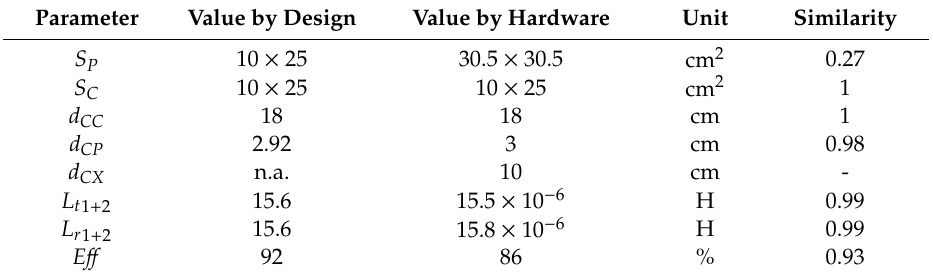
Table 7. Comparison of results between the design guidelines and the hardware implementation.